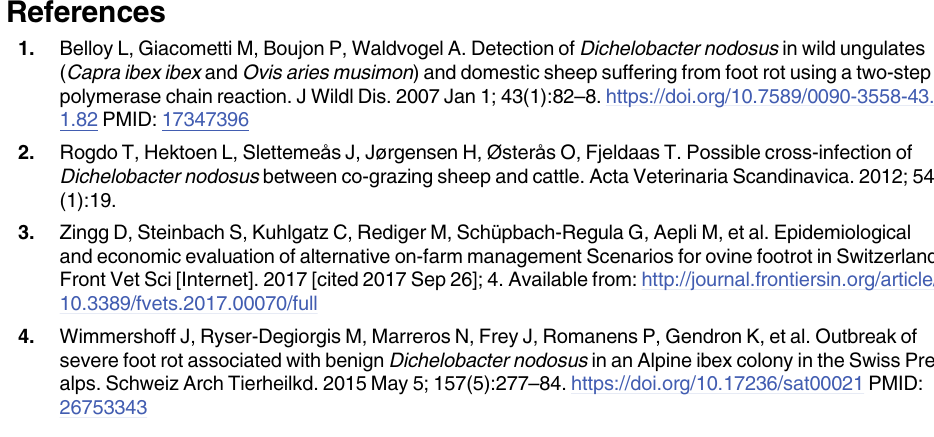
S1 Table. Cantons with PCR positive animals. Estimated true �� /apparent � prevalence of D . nodosus , with corresponding 95% confidence intervals indicated in parentheses and number of tested